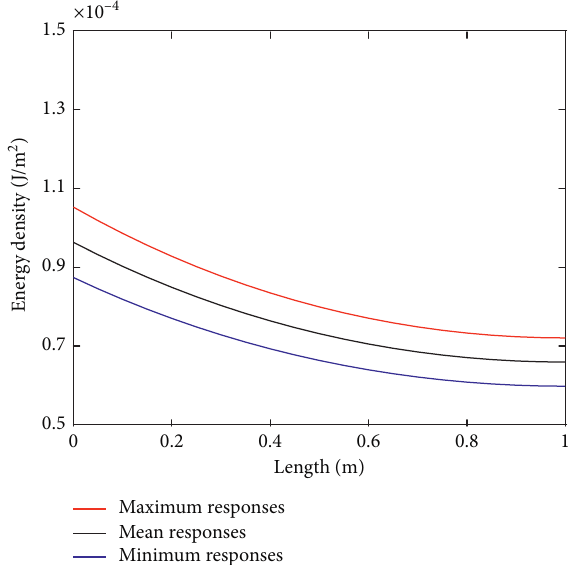
Figure 6: Energy density interval of the rod with a random-lo- cation excitation in